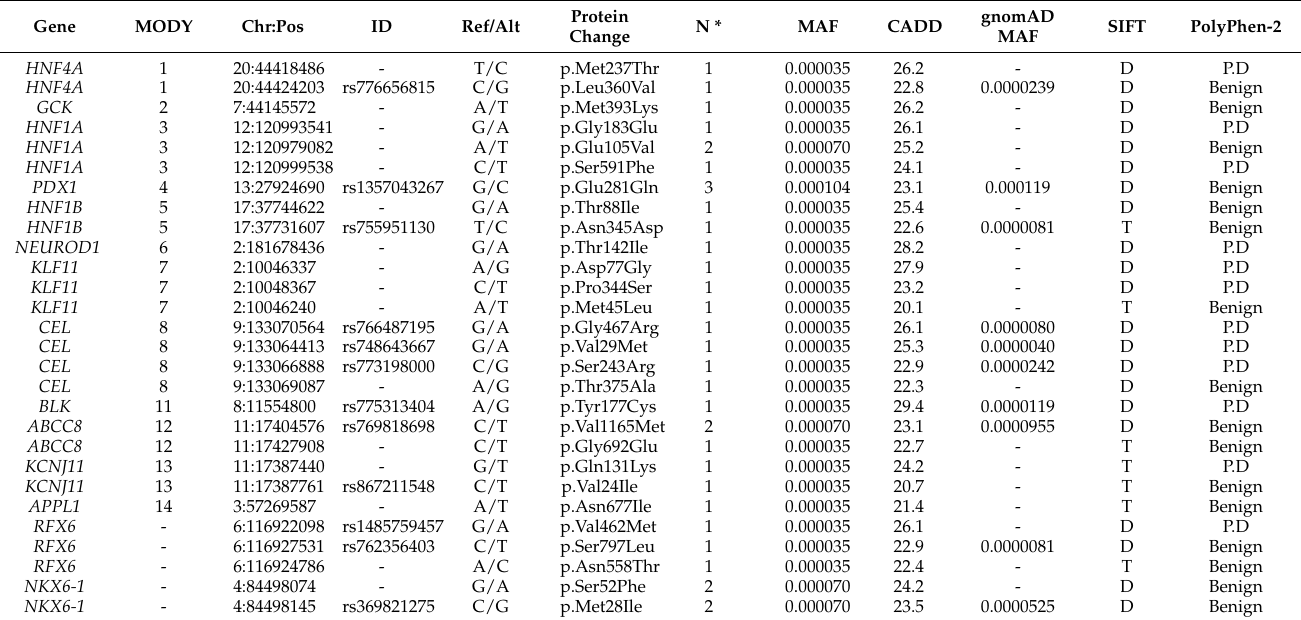
Table 4. Discovery of potentially novel fully penetrant MODY-causing mutations in the Qatar Biobank (QBB) cohort.